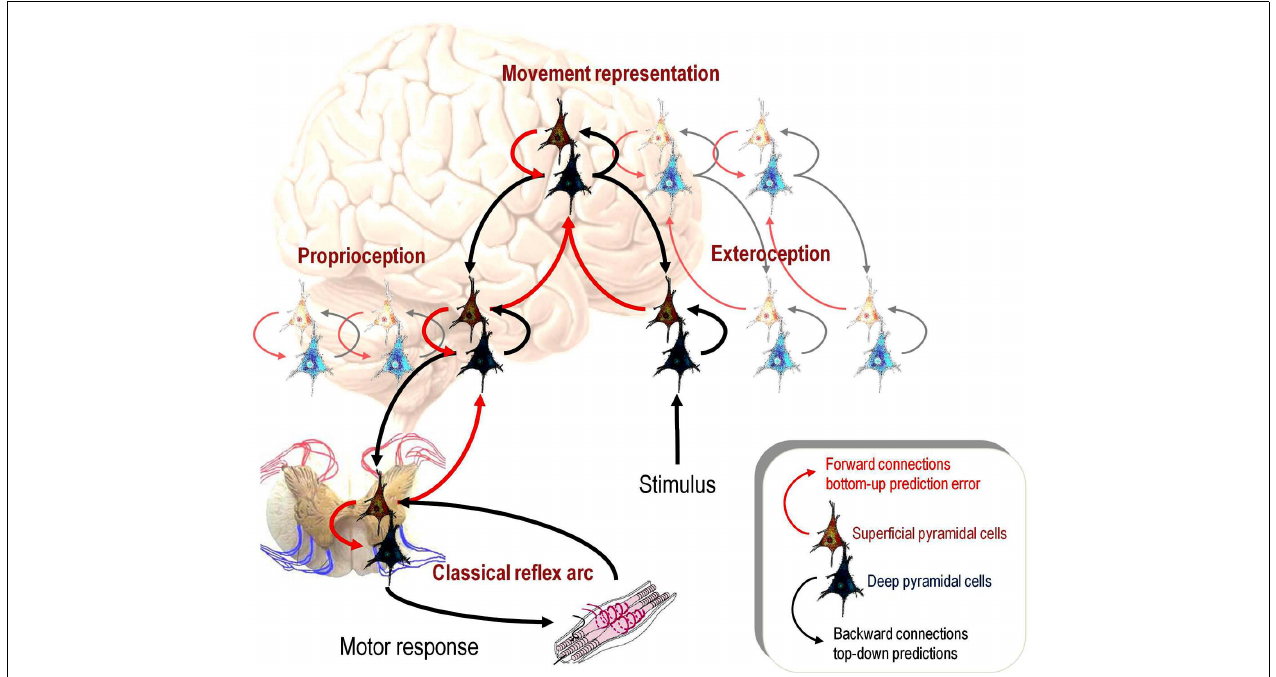
modalities can use prediction errors to drive motoneurons to eliminate prediction error directly (through classical motor reflex arcs).This is shown schematically on the lower left, using units in the dorsal and ventral horns of the spinal cord. Under active inference, a movement just fulfills the predictions afforded by percepts that predict both exteroceptive (e.g., visual) and interoceptive (e.g., stretch receptor) consequences.This high-level (sensorimotor) percept is activated by an exteroceptive (sensory) cue and the ensuing top-down predictions propagate to both sensory cortex (to suppress exteroceptive prediction error) and the motor system. However, in the motor system, the predictions engender a proprioceptive prediction error that is eliminated by movement. In this schematic, we have assumed that prediction errors are reported by superficial pyramidal cells (Mumford, 1992), while conditional representations are encoded by (top-down) projecting deep pyramidal cells. Darker units highlight those activated by the presentation of a